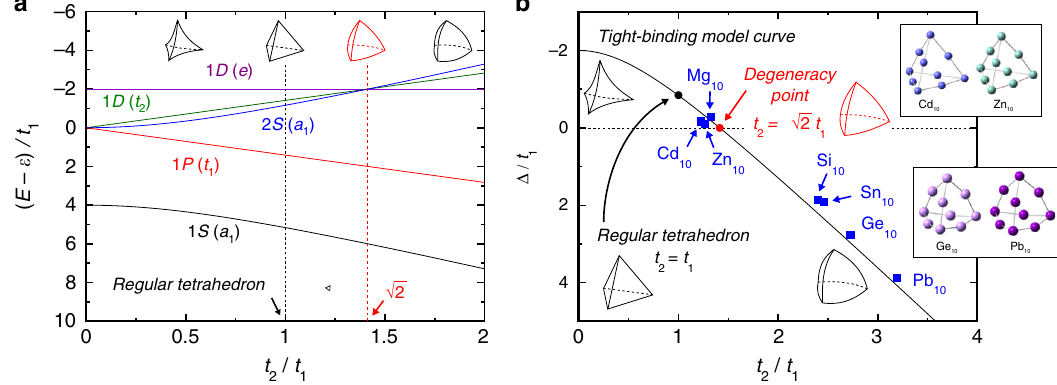
Fig. 3 The tight-binding model analysis for the ten-atom tetrahedral system. a Energy spectrum of H 10 . b Degree of level splitting, Δ / t 1 , vs. the transfer integral ratio, t 2 / t 1 . Blue squares indicate the DFT value of each level splitting. All the parameters were determined based on DFT calculations at the B3LYP/LanL2DZ level of theory (Table 1). DFT-based optimized structures are also